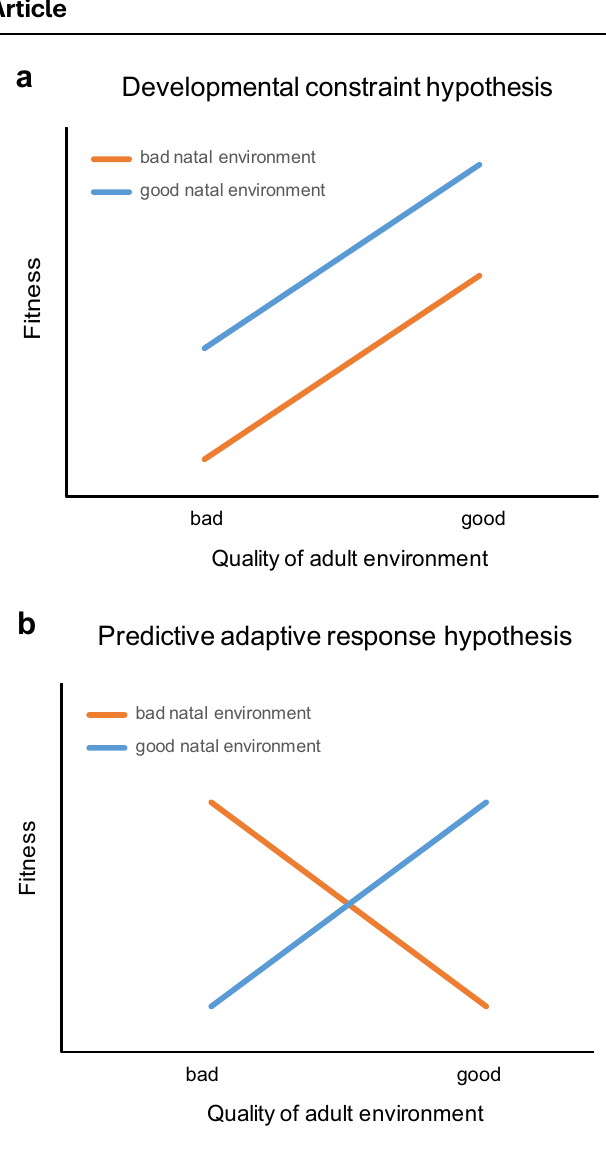
Fig. 1 | Two main hypotheses examine the fi tness effects of the interplay between conditions experienced during development and those encountered later in life. In the “ developmental constraint ” or “ silver spoon ” hypothesis ( a ), harsh conditions during early development constrain phenotype quality, under- mining its future fi tness, so that phenotypes generated in favourable settings are always superior to those generated under hardship regardless of the environment experiencedlaterinlife.Thus,foralllevelsofenvironmentalqualityencounteredin adult life (x-axis), the fi tness of individuals that experienced favourable (natal) conditions during development is always higher than the fi tness of those that experienced hardship during development (parallel lines of a ). In the “ predictive adaptiveresponse ” hypothesis(PAR, b ) individuals enjoya fi tness advantage when they encounter as adults the same environmental quality that they experienced duringdevelopment.Thus,forexample,the fi tnessofindividualsthatexperienced hardship during developmentis inferiorto the one of otherindividuals when adult conditions are favourable, but superior when adult conditions are again challen- ging. This results in the crossing lines of b . Readapted from refs.